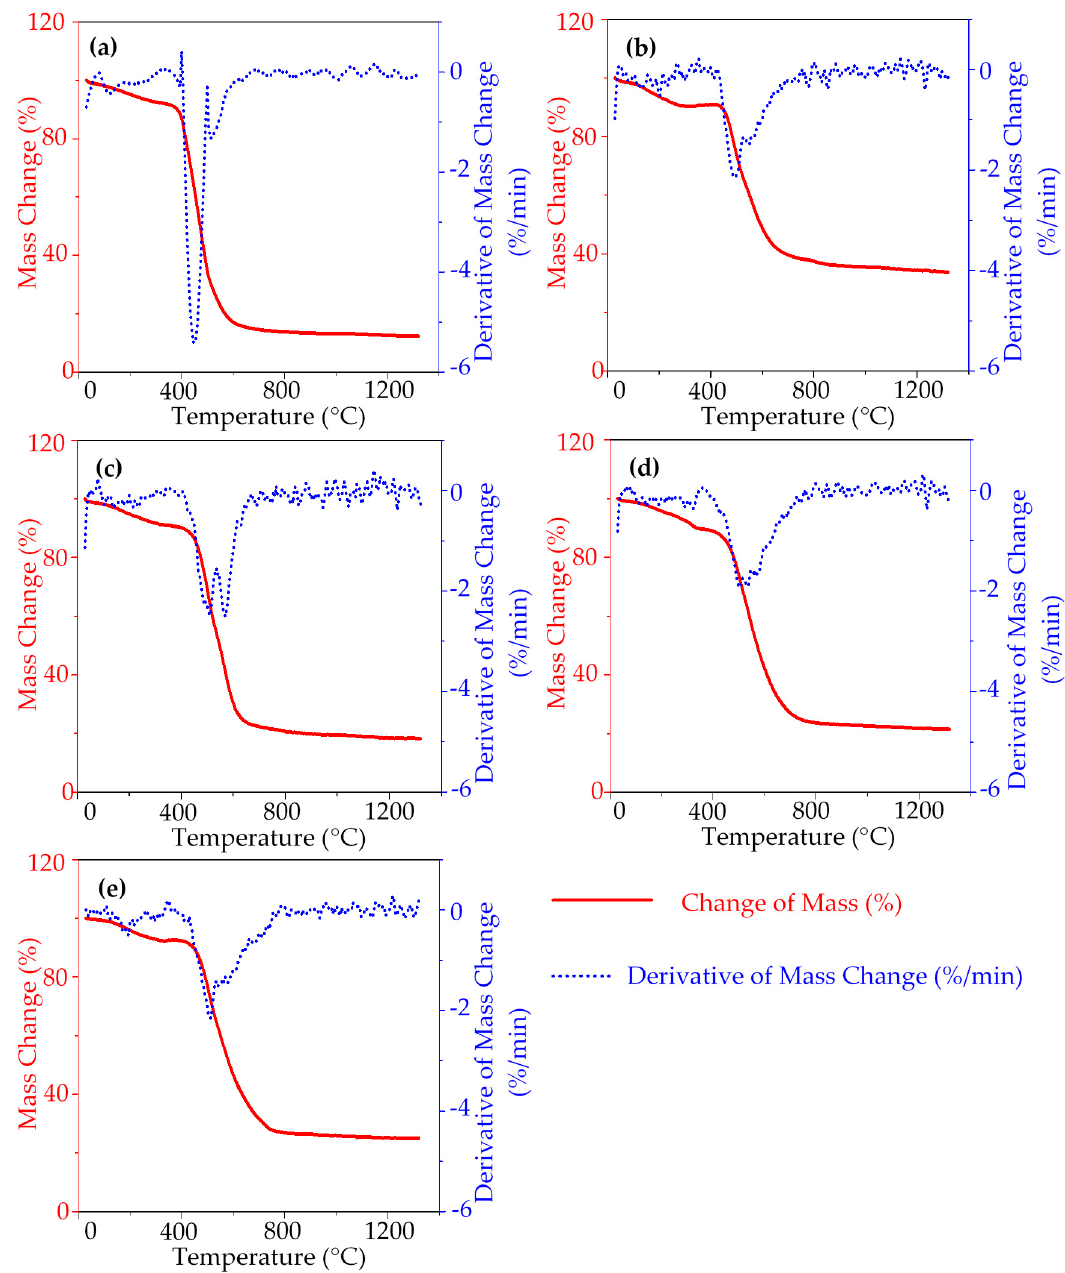
Figure 6. TGA curves of CNT synthesized from the fuels I–V: ( a ) Fuel I, ( b ) Fuel II, ( c ) Fuel III, ( d ) Fuel IV, ( e ) Fuel